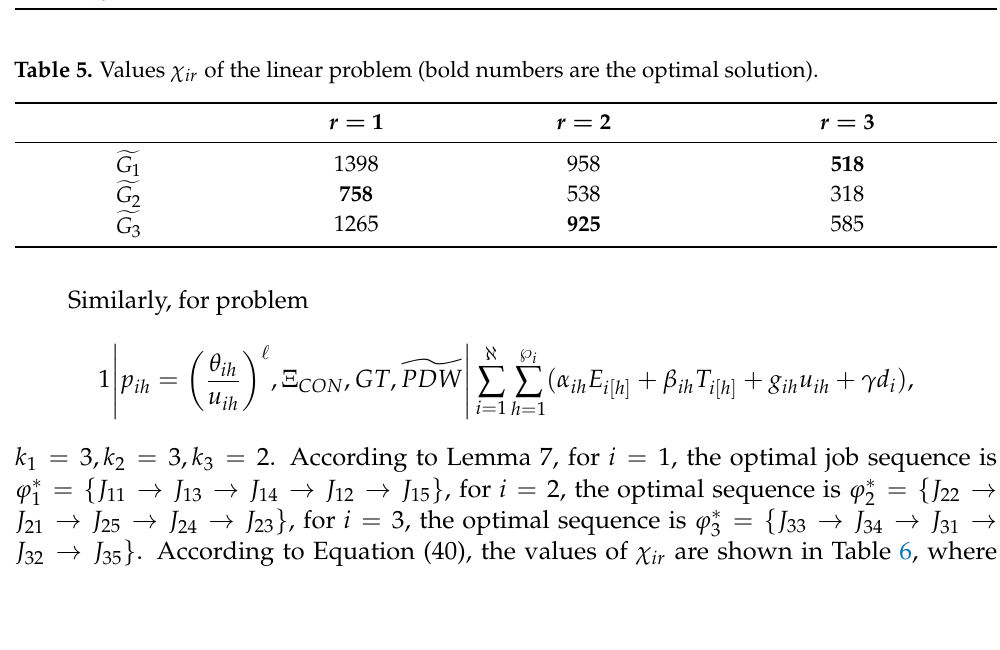
Table 4. Values ϑ